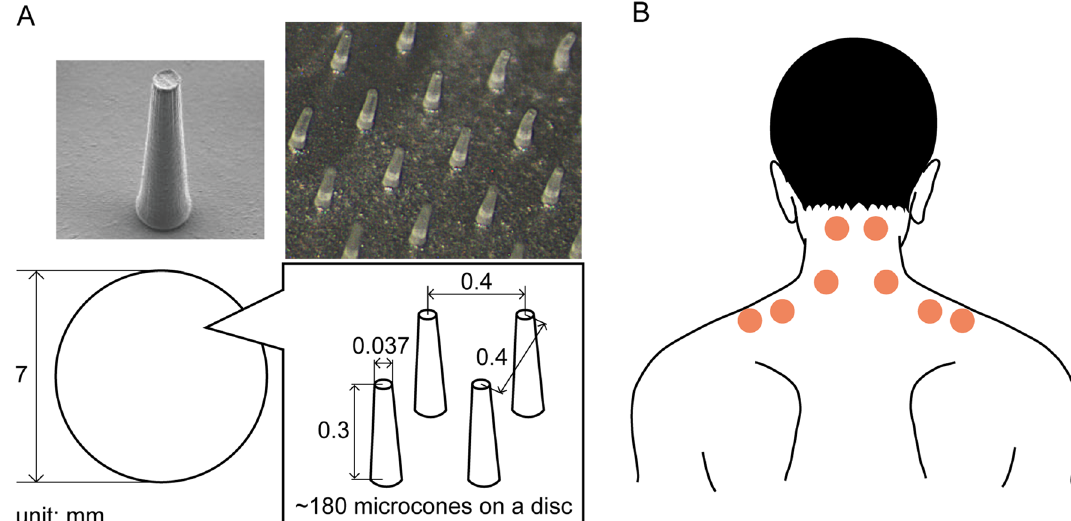
Fig. 1 Photographs and specification of a disc with microcones ( A ) and locations of microcone application ( B ). In panel ( A ), photographs of microcones taken by scanning electron microscopy (left top) and stereoscopic microscopy (right top) are presented, and a specification of microcones is shown in the enlarged view. Approximately 180 microcones are arrayed on a circular disc of 7 mm in diameter. The microcones were regularly arrayed on a disc with a pitch of 0.4 mm. Each microcone has a flat tip with a diameter of 0.037 mm and a height of 0.3 mm. The disc was fixed on the skin with adhesive tape. In panel ( B ), filled circles indicate the approximate locations of microcone application (up to eight locations on the left and right). The locations were slightly adjusted depending on participants’ perceived symptoms and palpations performed by a